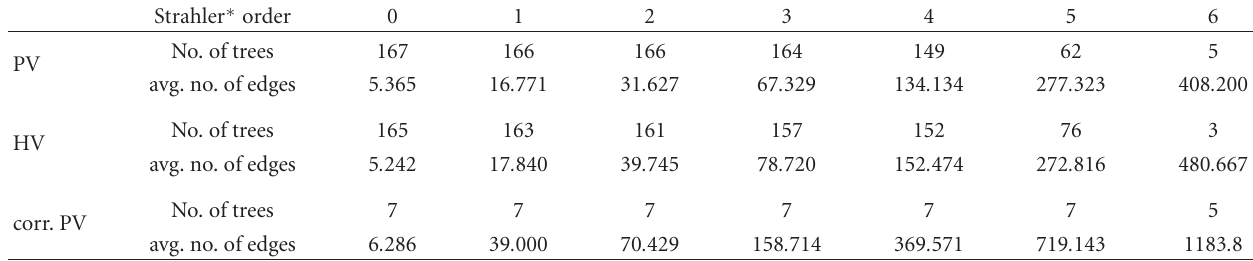
Table 1: Average number of human PV and HV trees considered for statistical analysis that have edges of Strahler ∗ orders 0 to 6, along with the average number of edges per tree where such edges are present.